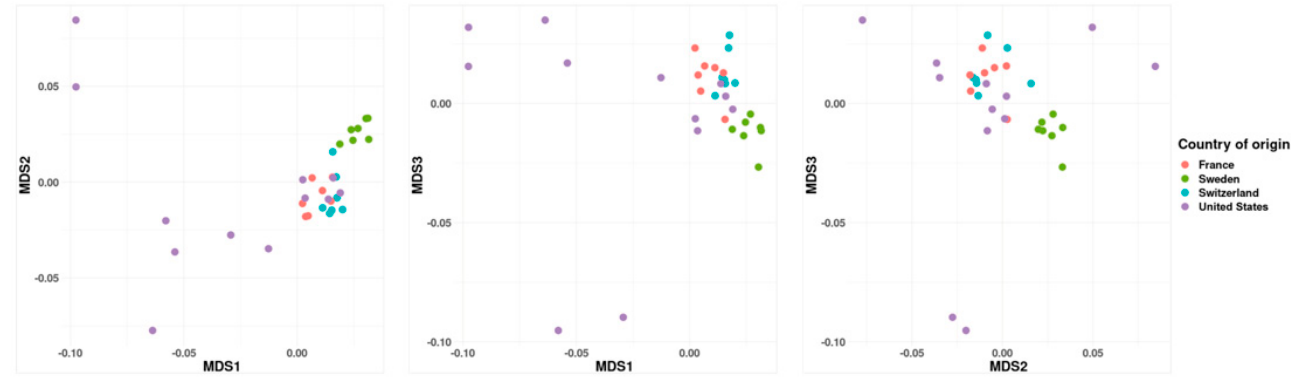
Figure 1. MDS analysis of the 33 dogs from four countries based on the first (MDS1), second (MDS2), and third (MDS3) dimensions using the LD-pruned variants dataset.